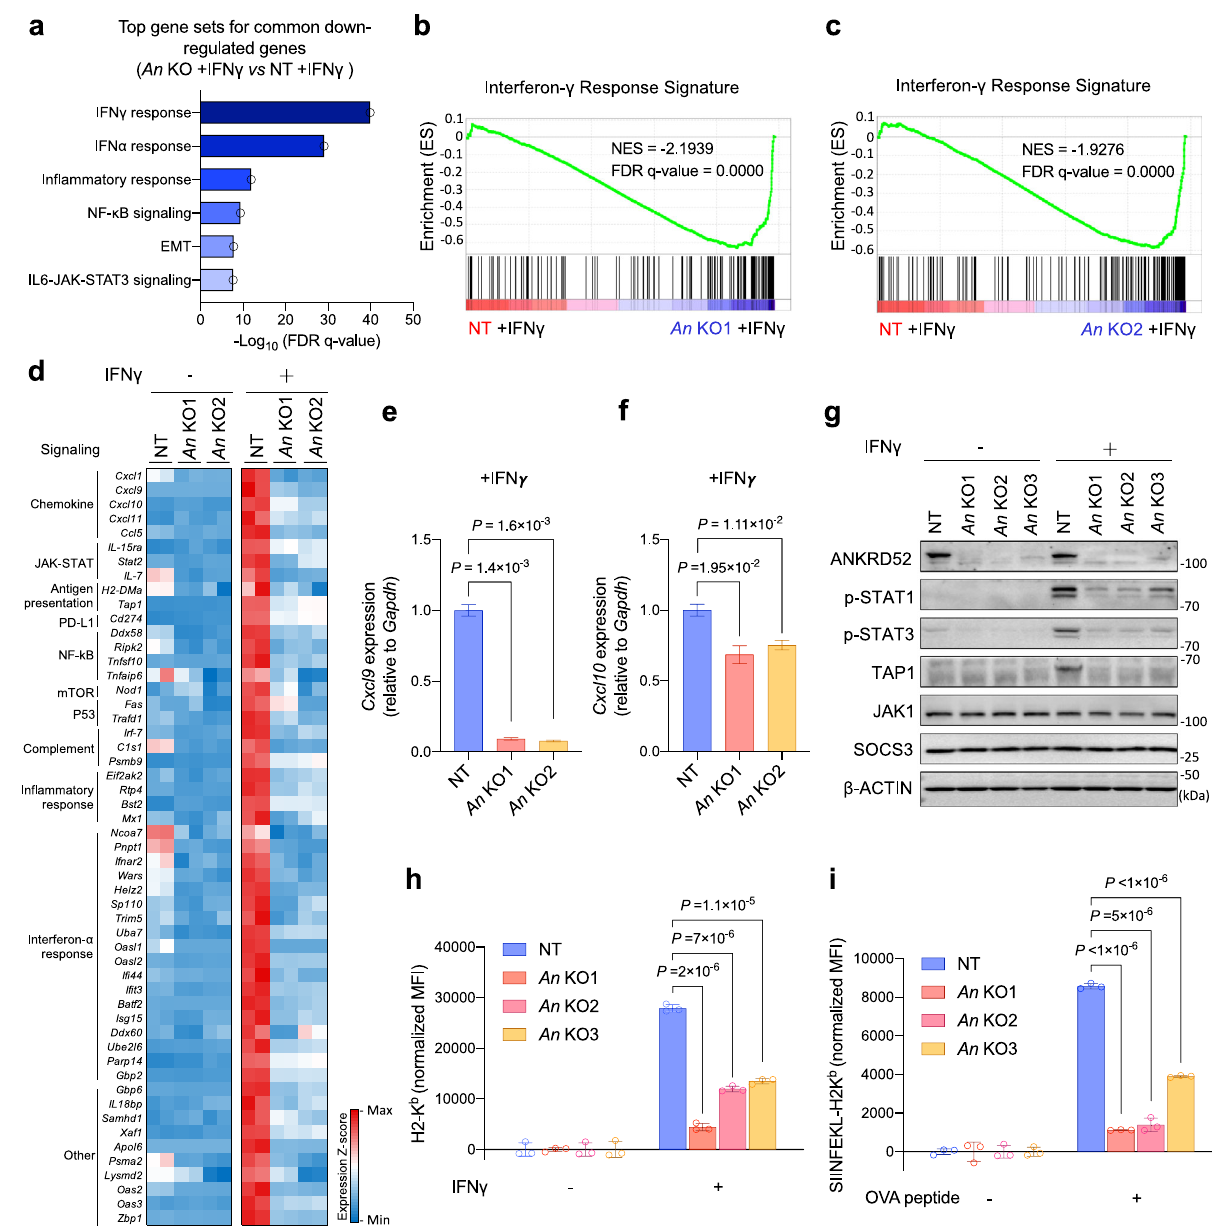
Fig. 4 ANKRD52 inactivation attenuates IFN γ signaling, chemokine expression, and antigen presentation. a Hallmark gene sets enriched for commonly down-regulated genes in Ankrd52 -null (both An KO1 and An KO2, 1.5-fold-change cut-off, P < 0.05, analyzed by edgeR) MC38 cells compared to control cells after IFN γ treatment. b , c Enrichment of genes associated with IFN γ response in Ankrd52 -null cells exposed to IFN γ . d Heatmap showing down- regulated IFN γ responsive gene expression in Ankrd52 -null cells by RNA-seq analysis ( n = 2 per group per condition). e , f Cxcl9 ( e ) and Cxcl10 ( f ) mRNA level in control and ANKRD52 -null MC38 cells treated with IFN γ ( n = 3 per group). Data are representative of two independent experiments and represented as mean ± s.e.m., signi fi cance was determined using two-tailed unpaired Student ’ s t -test. g Abundance of IFN γ signaling proteins in control and Ankrd52 -null MC38 cells treated with IFN γ . Data are representative of fi ve independent experiments. h Abundance of membrane MHC-I expression in control and Ankrd52 -null MC38 cells after treatment with IFN γ . MFI (mean fl uorescence intensity) of H2-K b was normalized by the responding group without IFN γ treatment ( n = 3 per group per condition). Data are representative of four independent experiments and represented as mean ± s.d., signi fi cance was determined using two-tailed unpaired Student ’ s t -test. i Presentation of OVA-derived peptide (SIINFEKL) in OVA-treated control and Ankrd52 -null MC38 cells. MFI of SIINFEKL-H2K b was normalized by the responding group without IFN γ treatment ( n = 3 per group per condition). Data are representative of three independent experiments and represented as mean ± s.d., signi fi cance was determined using two-tailed unpaired Student ’ s t -test. See also Supplementary Figs. 8 and 9. Source data are provided as a source data fi